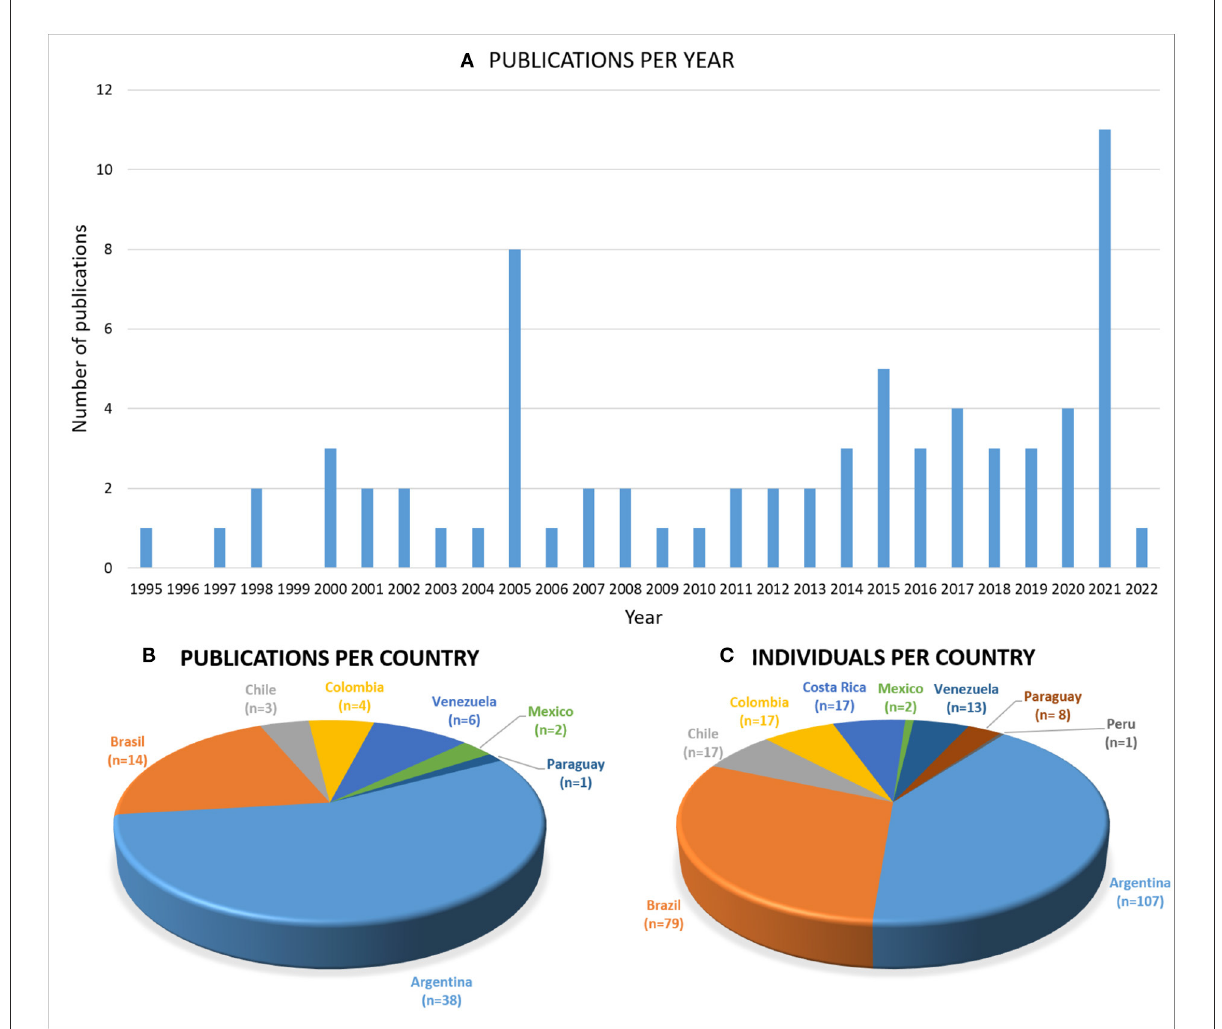
FIGURE1 The SA & C publications. Graphs showing (A) the publications per year and (B) per country, and (C) the number of individuals described per SA & C country. All types of publications in public databases were collected. The country mentioned in affiliations was taken, even if the author from SA & C was not leading the article. An increasing number of publications (mainly on CLN2) was observed in the last few years. Argentina and Brazil are the most represented regarding the number of publications and individuals described, probably due to the increasing number of professionals and centers specialized in these